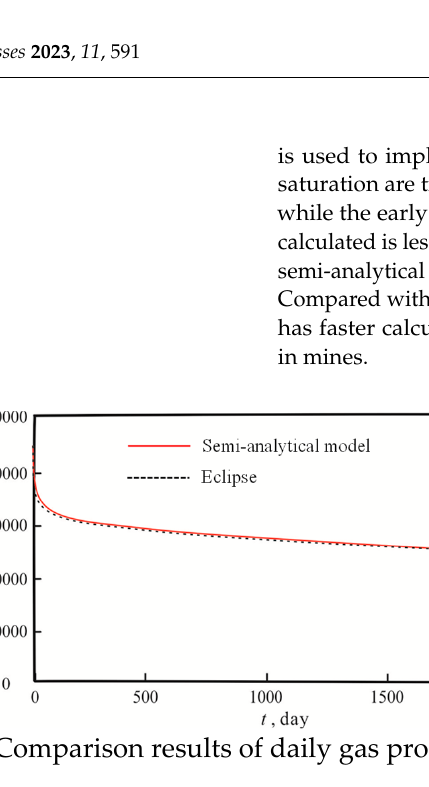
12 of 17 . Figure 2. Schematic of the gas PVT properties. Figure 3. Relative permeability of the natural fracture system. The comparison results of the semi-analytical model and Eclipse in this paper are shown in Figure 4. It can be seen that the output curves obtained using the two methods are somewhat different in the early production period, and the results are basically the